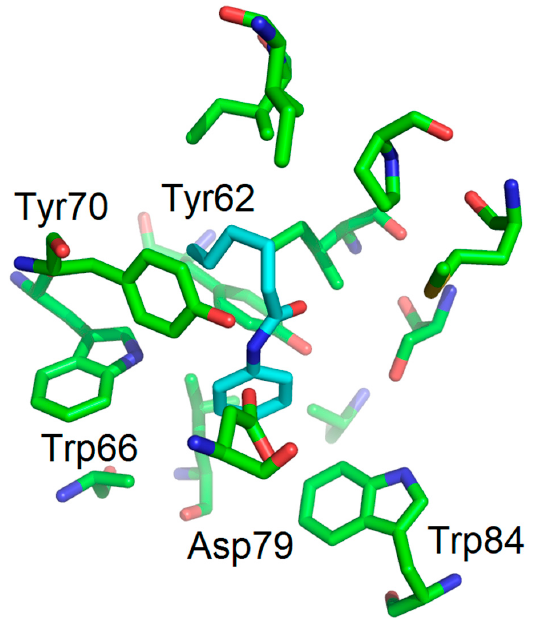
Figure 7. The binding mode (molecular docking) of compound 12 (cyan) shows a good fit, through hydrogen bonding, with Asp79 (NH).